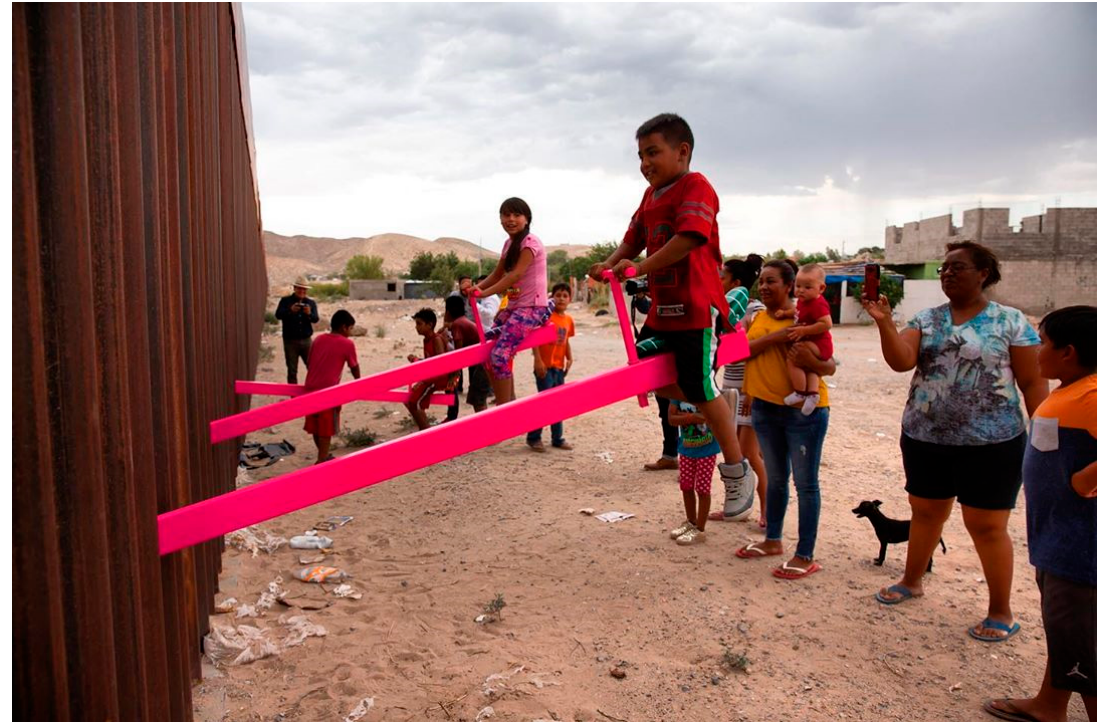
Figure 11. Children playing with installed teeter-totter (Photo graciously provided by Ronal Rael). The Teeter-Totter Wall was installed in 2019 on the borderwall between Puerto de Anapra, Mexico, and Sunland Park, New Mexico (Barajas 2019; Brice 2019). The installation consisted of three neon pink metal teeter-totters, also commonly referred to as seesaws, not much different than those one may encounter at a public playground. These teeter-totters were constructed in Mexico and then brought to the border where the beams were slid between, and then attached to, the vertical beams of the border wall. The seats and handles were then attached to the teeter-totter beams to create